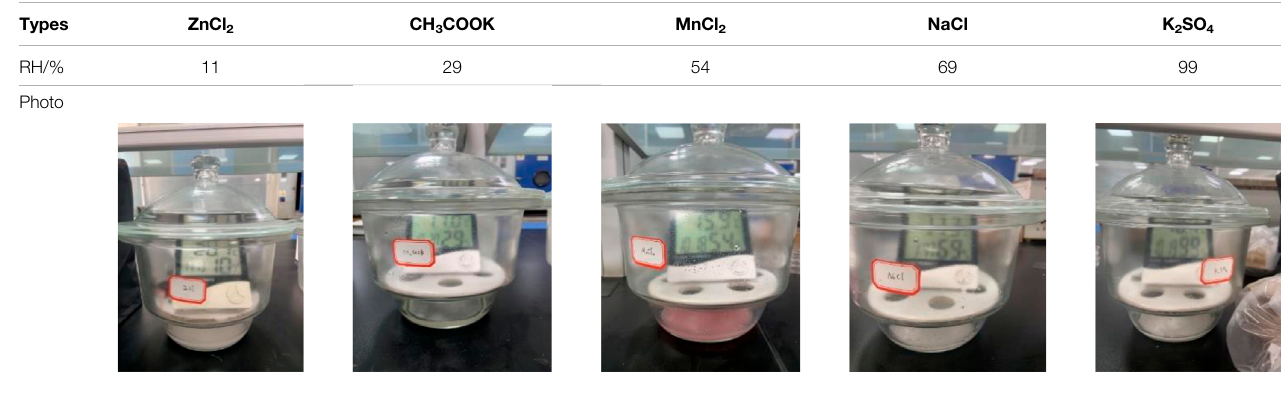
TABLE 2 | Relative humidity of different saturated salt